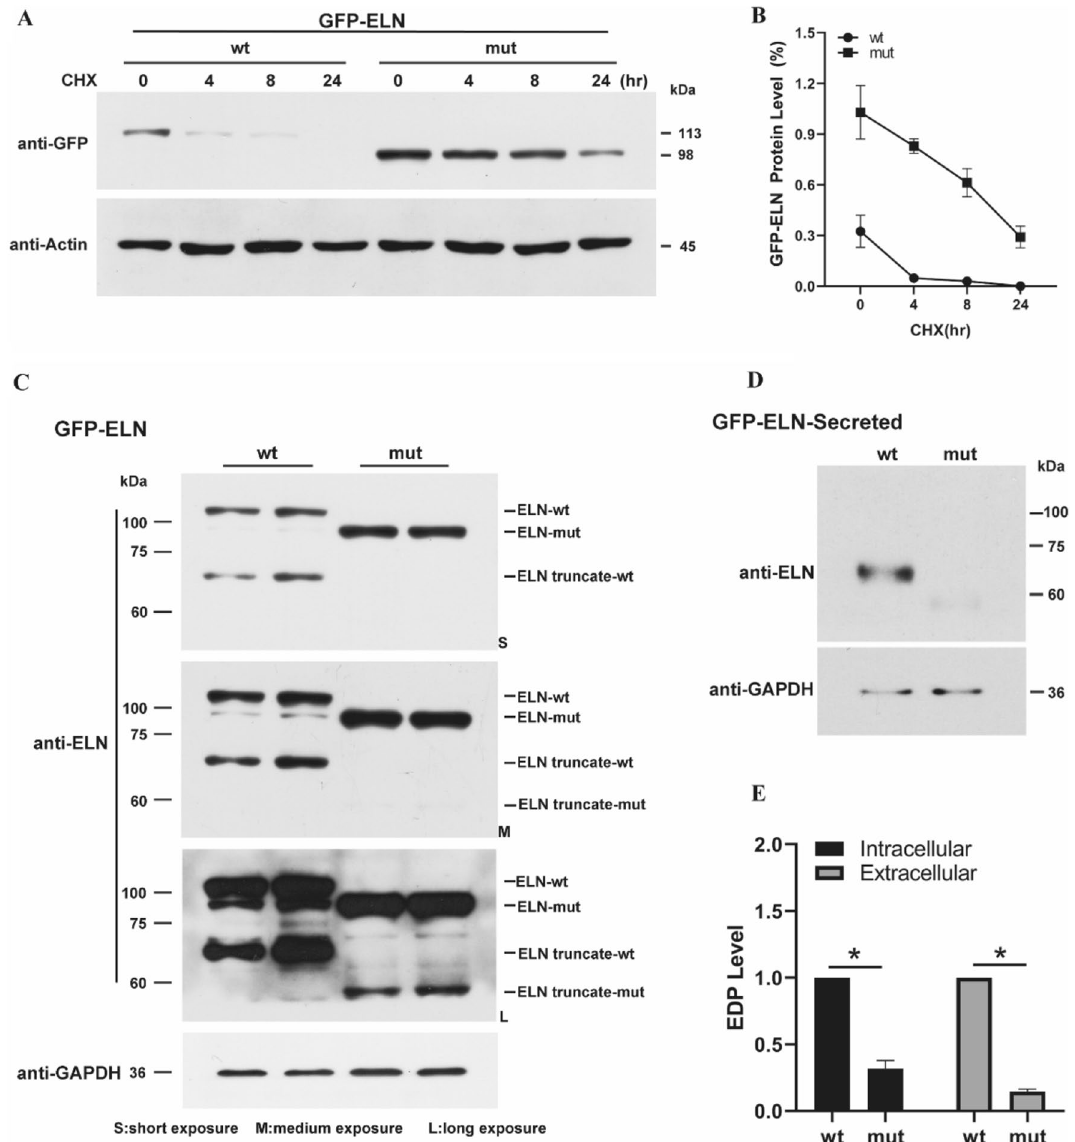
Figure 5. Effects of CHX on ELN expression and its relative secreted expression. ( A ) Effects of CHX on ELN expression in transfected cells. Immunoblot of GFP protein levels between the pEGFP-ELN-wt and pEGFP- ELN-mut group after incubation with CHX (500 μM) for 0, 4, 8, and 24 h. ( B ) Quantification of relative ELN protein levels in transfected cells. ( C ) The relative quantity of ELN and its truncated body under different exposure times. ( D ) Immunoblot of secreted ELN protein levels. ( E ) Quantification of ELN shear body relative protein levels. Values are means ± SEM. * P < 0.05, ** P < 0.01 was considered significant (N =